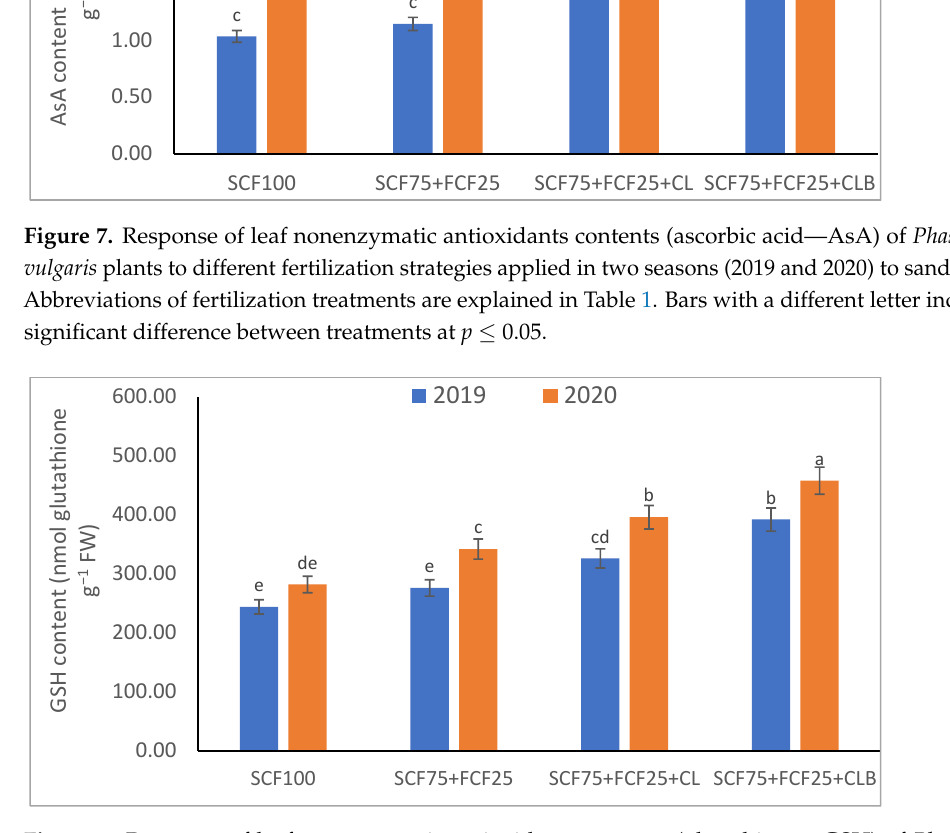
Figure 8. Response of leaf nonenzymatic antioxidants contents (glutathione—GSH) of Phaseolus vulgaris plants to different fertilization strategies applied in two seasons (2019 and 2020) to sandy soil. Abbreviations of fertilization treatments are explained in Table 1. Bars with a different letter indicate significant difference between treatments at p ≤ 0.05.